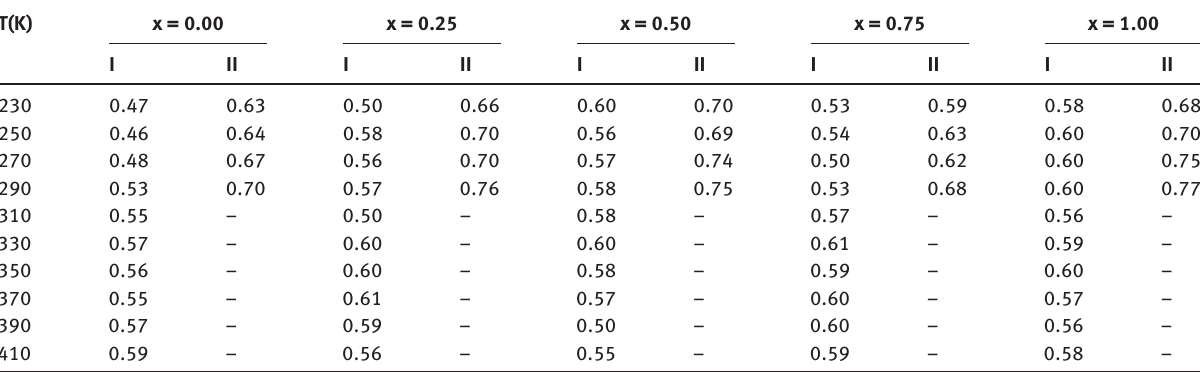
Table 1: The calculated a values for all the samples T(K)